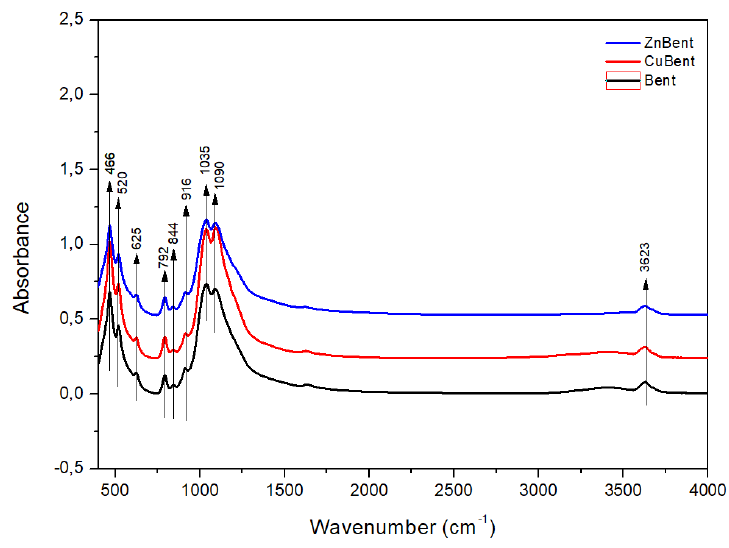
Figure 2. FT-IR spectra diagram of Bent, ZnBent, and CuBent and powder samples.